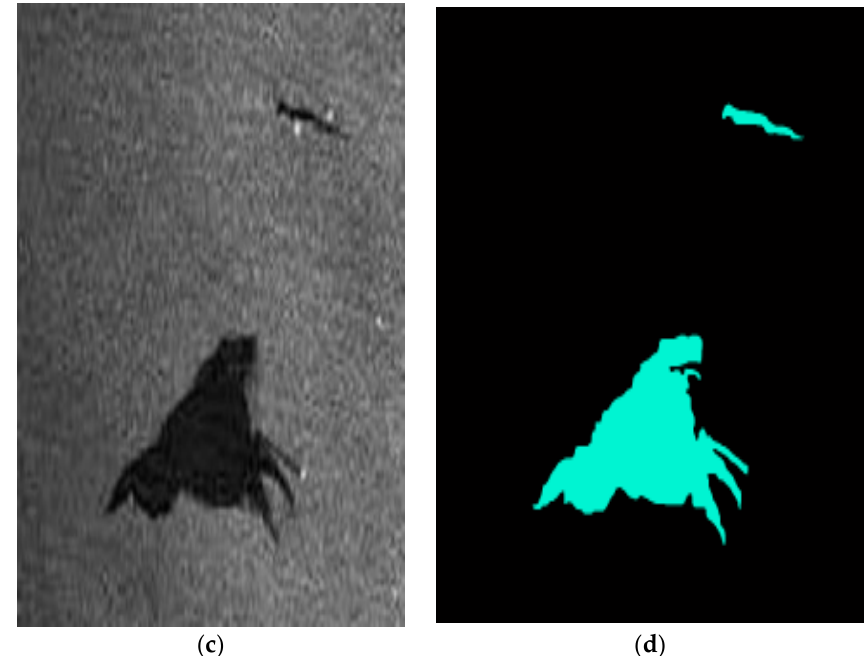
Figure 5. Some SAR images and labels in our datasets. ( a , c ) are SAR images taken by RADARSAT-2. ( b , d ) are labels labeled by ourselves. Light blue is the oil spill area.